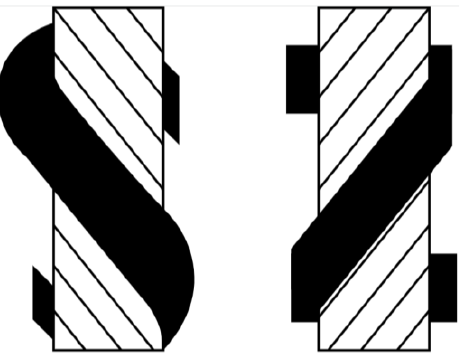
Figure 12. Illustration of the types of yarn twist orientation (Adapted from [18]).